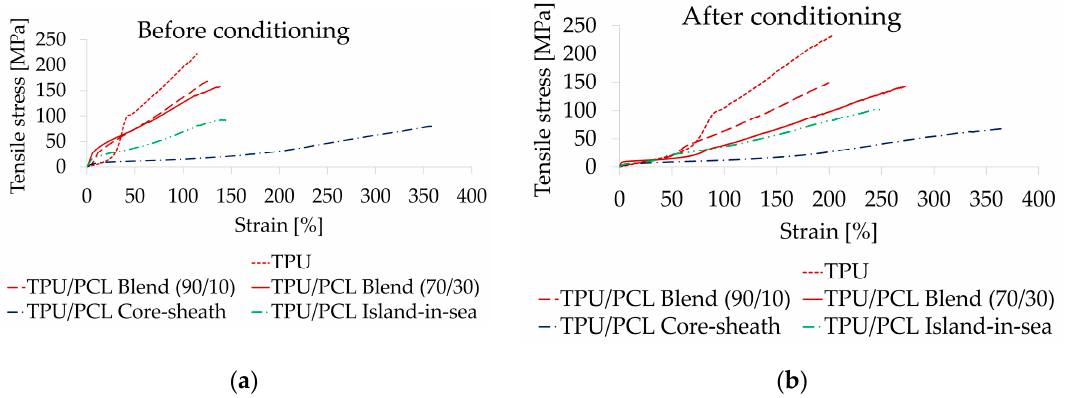
Figure 3. Stress-strain curves up to maximum strength for representative heat conditioned yarn samples before ( a ) and after ( b ) heat conditioning at 50 ◦